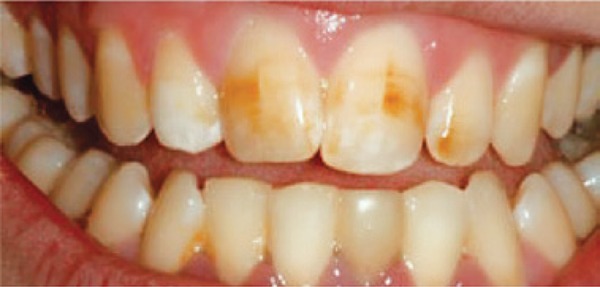
Dentes com fluorose moderada